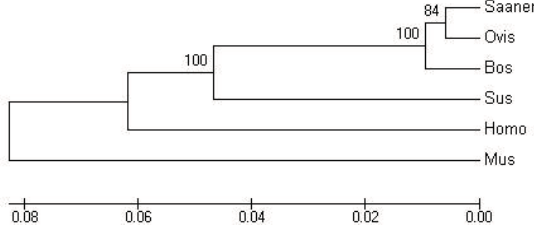
Figure 1. Neighbor-joining (NJ) phylogeny describing the similarity of CDS sequence of goat (Capra) LPL gene with the sequences of sheep (Ovis), bovine (Bos), pig (Sus), human (Homo), and mouse